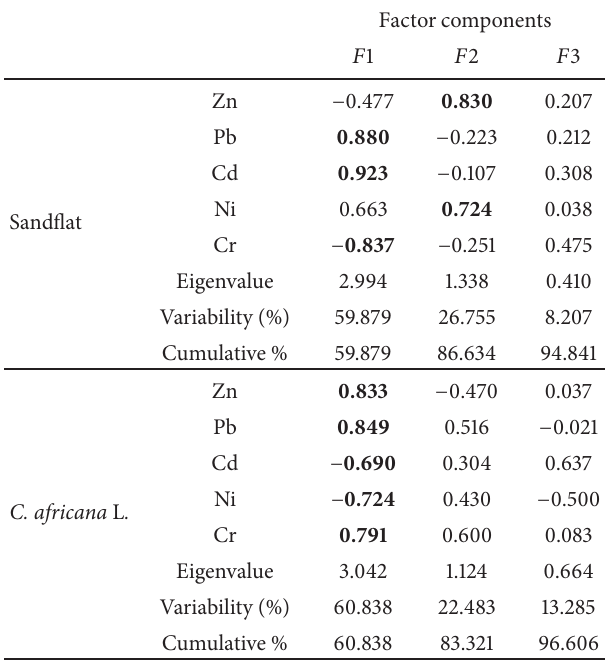
Table 6: PCA factor loadings of the concentrations of trace metals for sandflat soil and C. africana L .